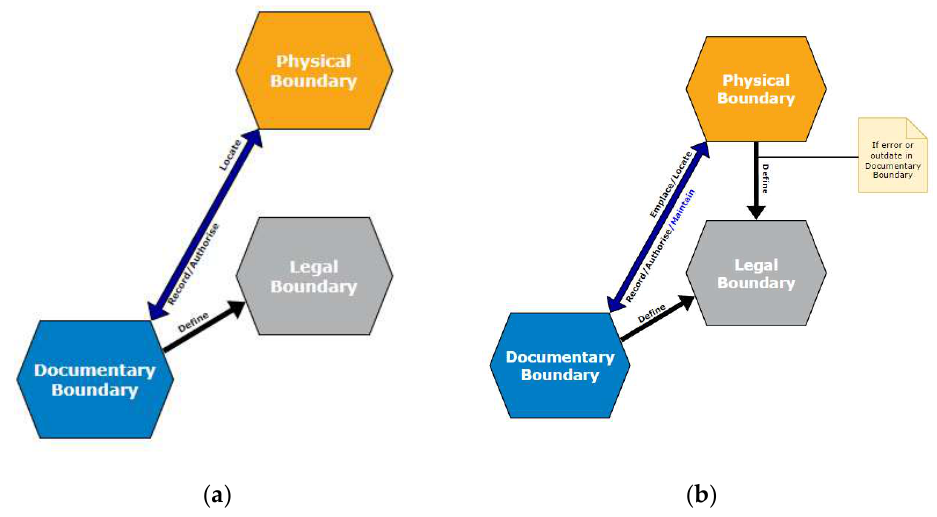
Figure 6. Evaluation of land boundaries and inconsistencies based on cadastral triangular model (CTM); ( a ) CTM for static model in pre-digitisation period; ( b ) CTM for dynamic model/maintenance in pre-digitisation period.